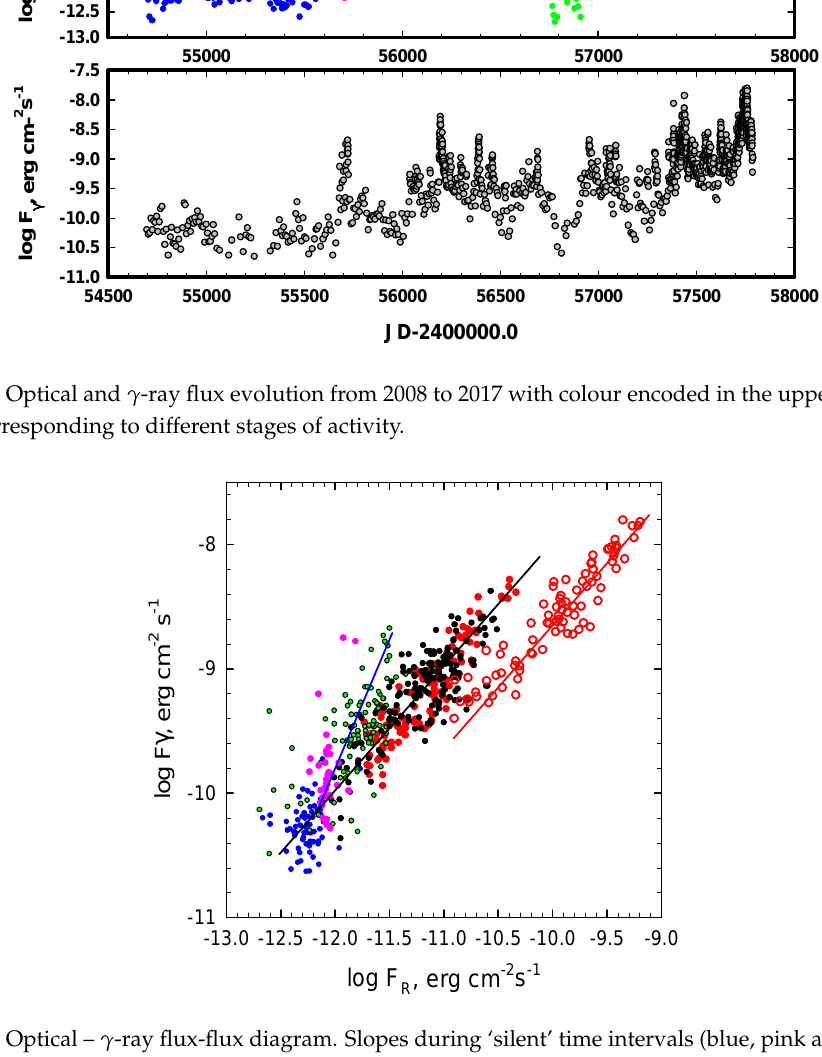
Figure 4. Optical – γ -ray flux-flux diagram. Slopes during ‘silent’ time intervals (blue, pink and green circles) are close to 2. A slope close to 1 is observed during periods of higher activity. The exceptional outburst of 2016–2017 (red open circles) also follows a slope of unity, but is substantially (0.6 dex down) displaced from the measurements of the previous